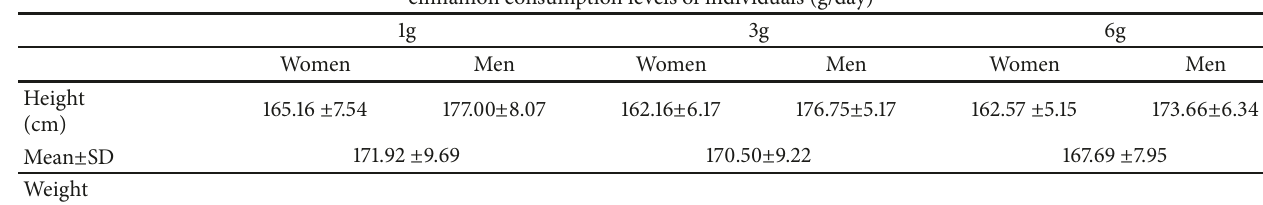
Table 2: Distribution of the cinnamon-consuming individuals according to their anthropometric